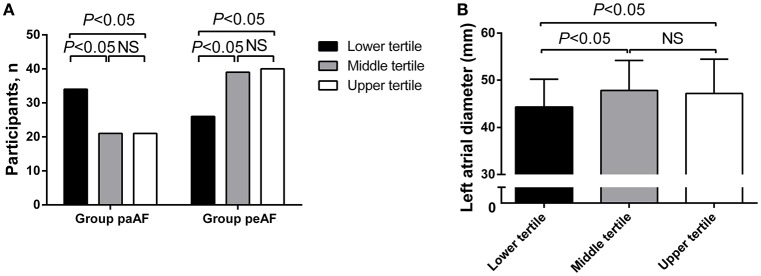
Differences in number of participants (A) and left atrial diameter (B) in the Group paAF and the Group peAF by tertile of circulating Cav-3 concentrations.